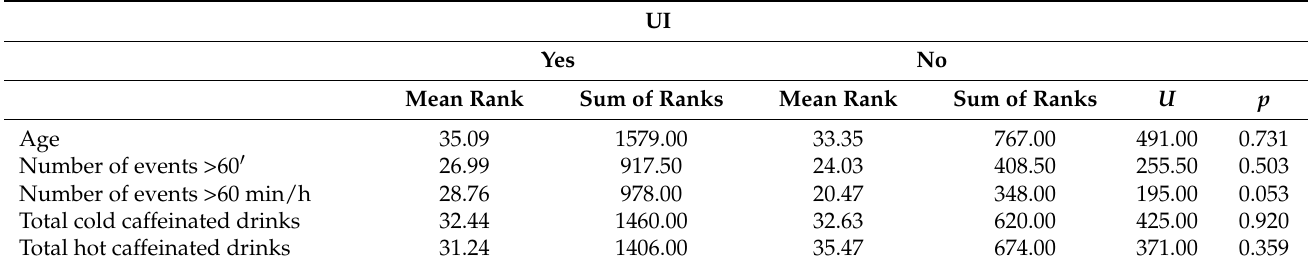
Table A3. Non-significant results ( p value over 0.200) between UI and non-parametric